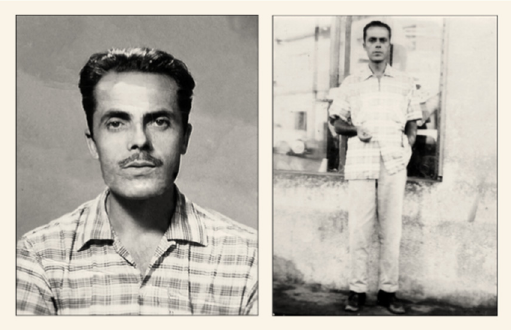
Figure 1. Virtudes (e misterioso) Xesús Fraga (2020, p. 297). Reprinted with permission from Xesús